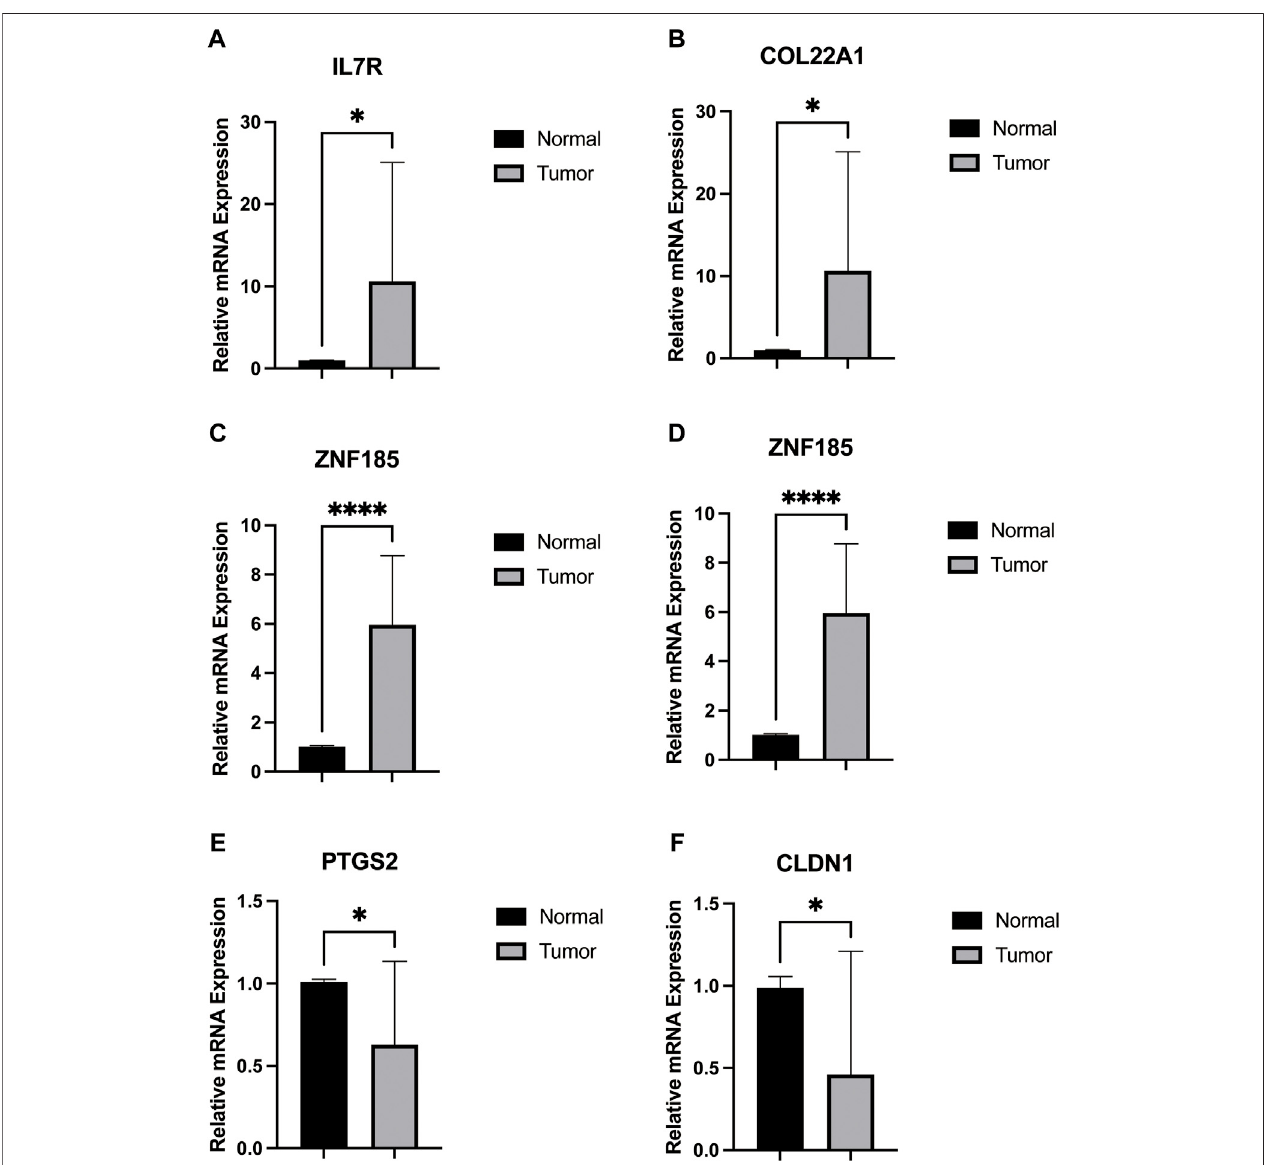
FIGURE 5 | mRNA expression of 12 paired prostate tumors and normal tissues obtained from